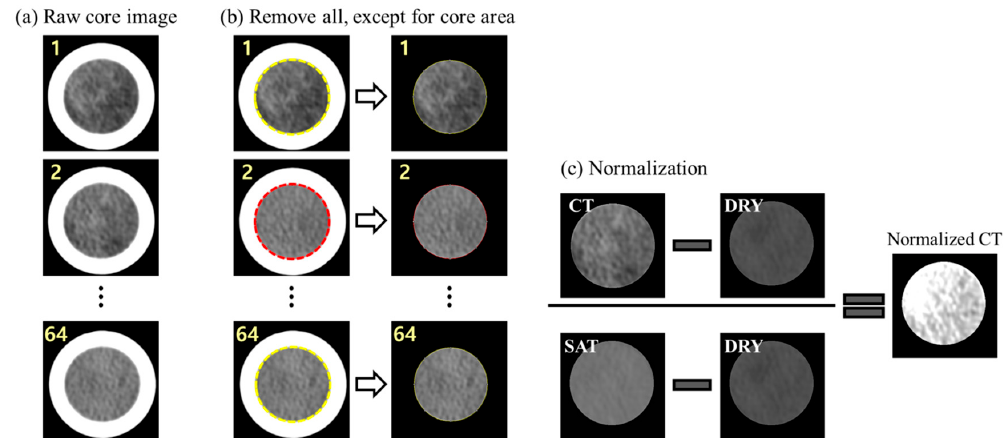
Figure 3. Modification and normalization of the CT images using ImageJ software [16]. ( a ) Acquisition of raw core images from the first to the sixty-fourth slice; ( b ) editing given images to acquire the target circle area; ( c ) normalization with CT images of DRY and SAT for standardization.